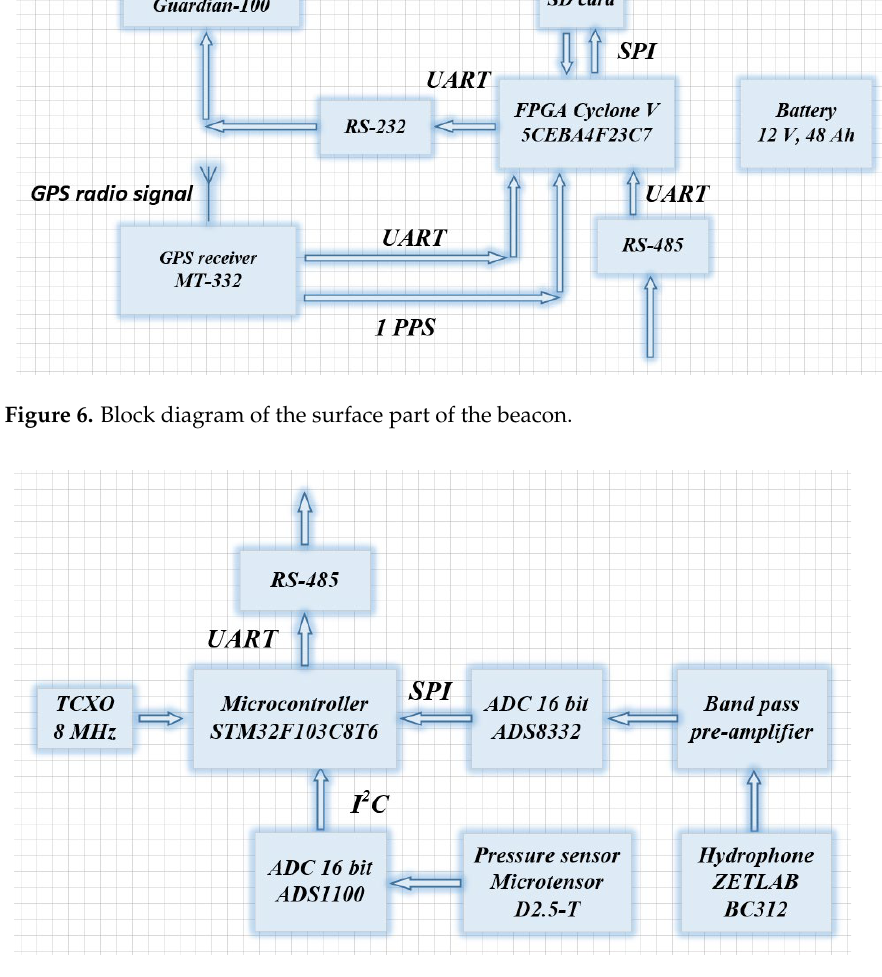
Figure 7. Block diagram of the submersible part of the beacon.